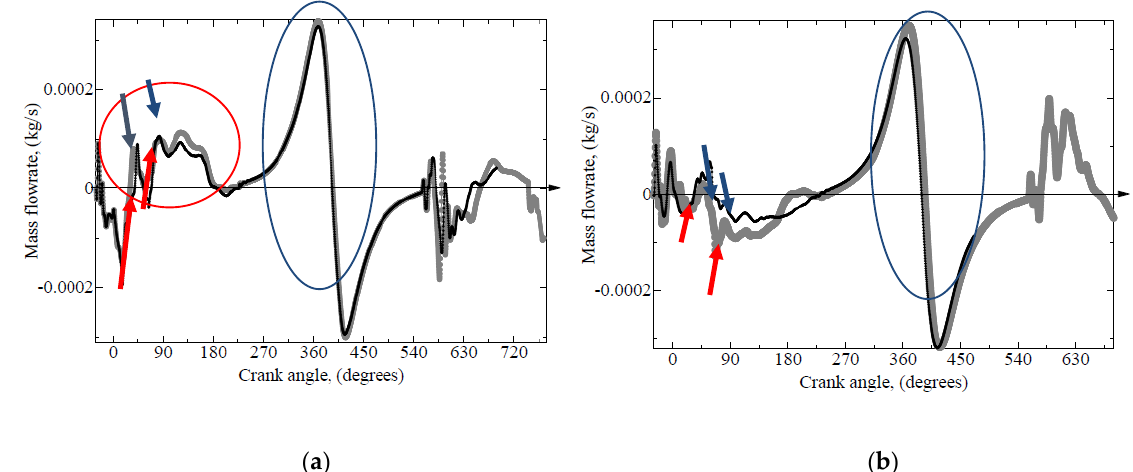
Figure 7. Mass flow rates of the outlet ducts of the prechamber with chamfered edges (gray line) and sharp edge (black line). ( a ) Mass flow rates in inlet ducts for both designs, ( b ) Mass flow rates in outlet ducts for both designs.